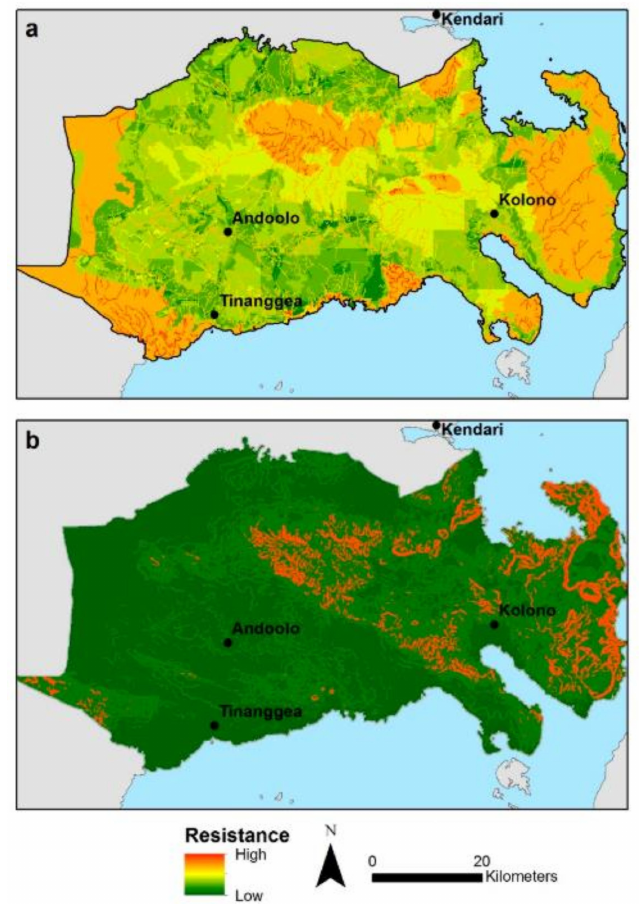
Figure 6. Example of the cost surface produced through ( a ) combining all the weighted GIS layers representing each of the subfactors where spatial data was available for local regions and ( b ) using only topography where high-resistance areas have higher slope values